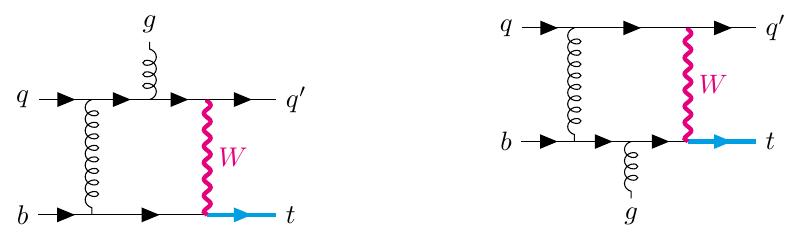
Figure 2. Examples of diagrams contributing to amplitudes B sL defined through colour decomposition in eq.